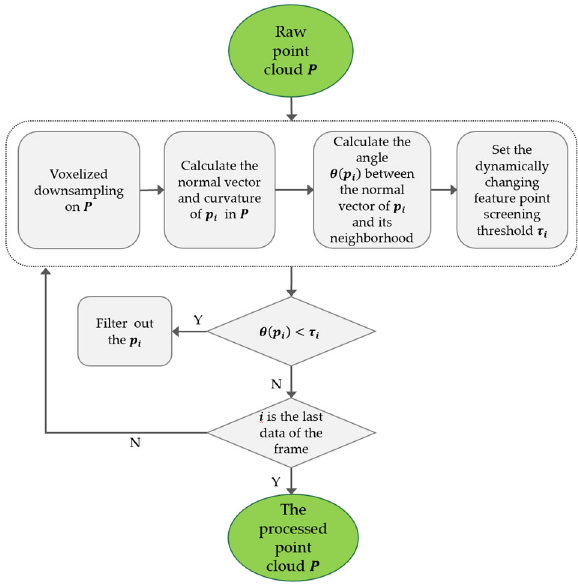
Figure 4. Feature described by surface information extraction.